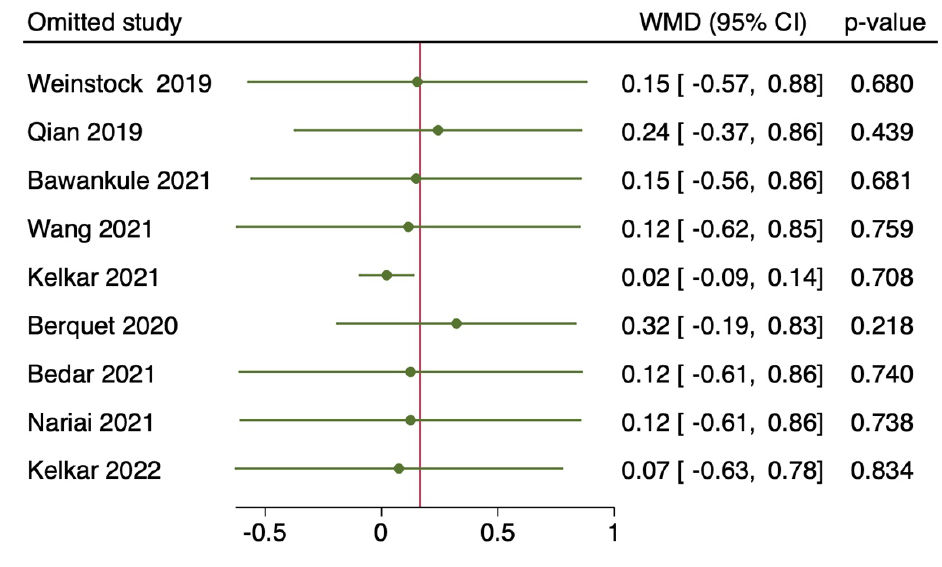
distance, 2 lines (dotted green lines) created an interval in which seven studies (in small circles) fell, indicating 2 potential outliers.